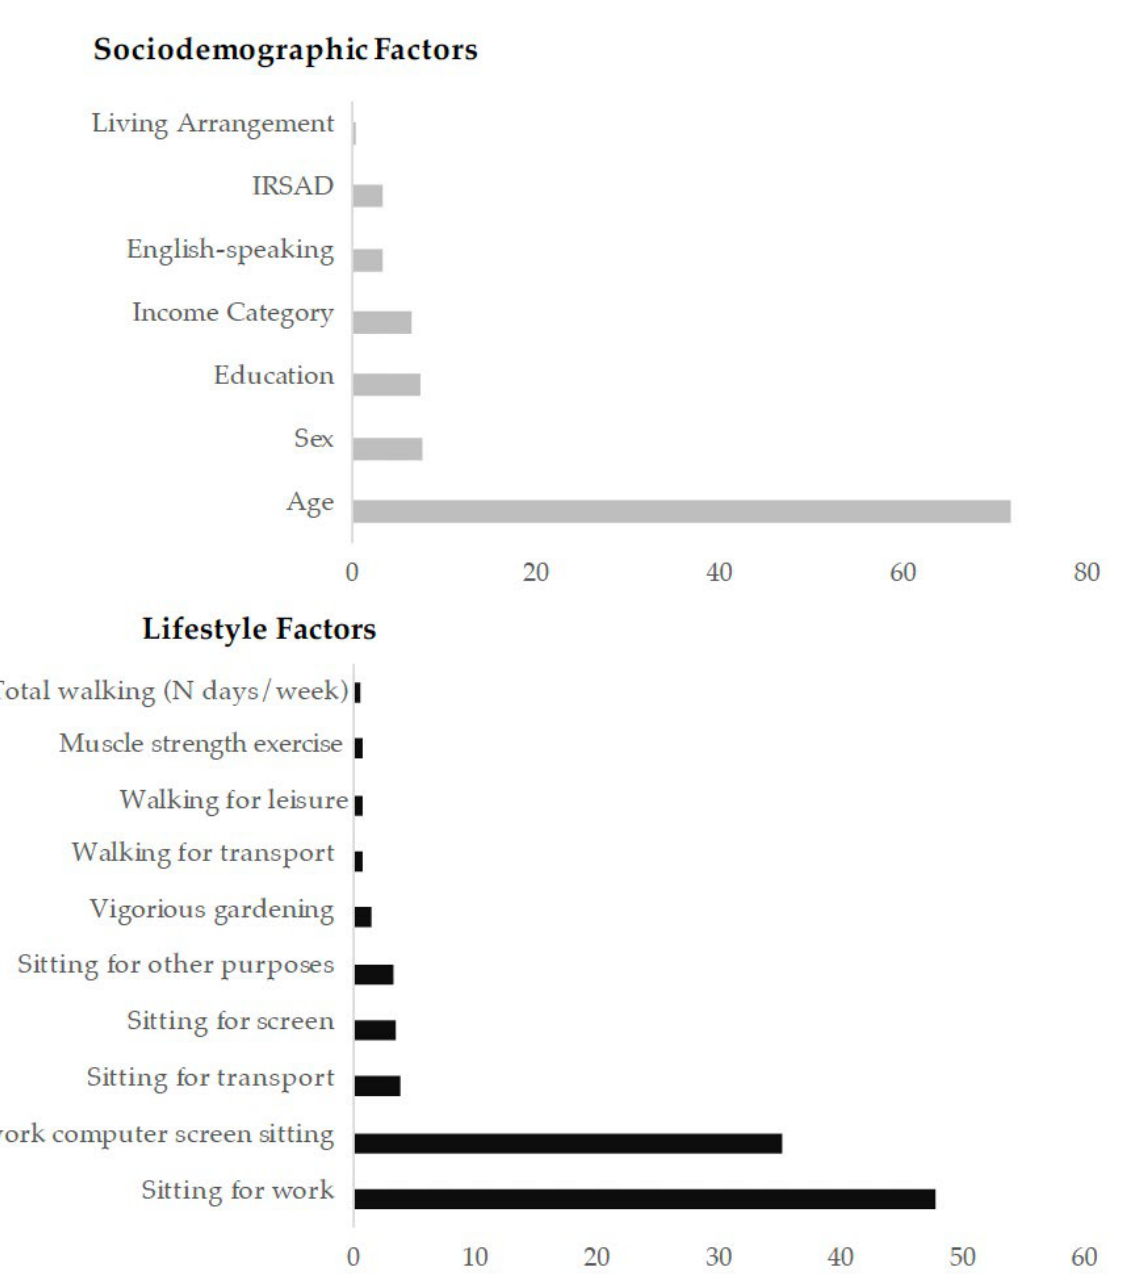
Figure 2. Relative contribution of the sociodemographic and lifestyle factors for predicting cognitive classes using gradient boosting machine.